Question: What visual encoding does this figure use to show its data?
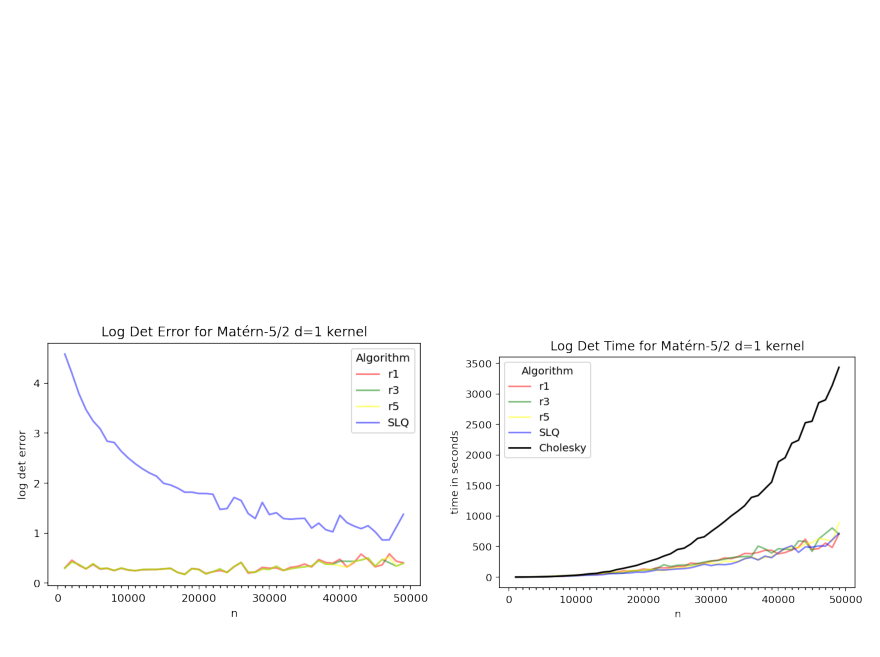
Answer: line